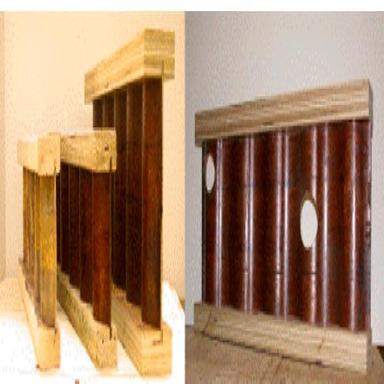
Wood-based I-joists with 5 mm, corrugated, veneer-waste web elements.